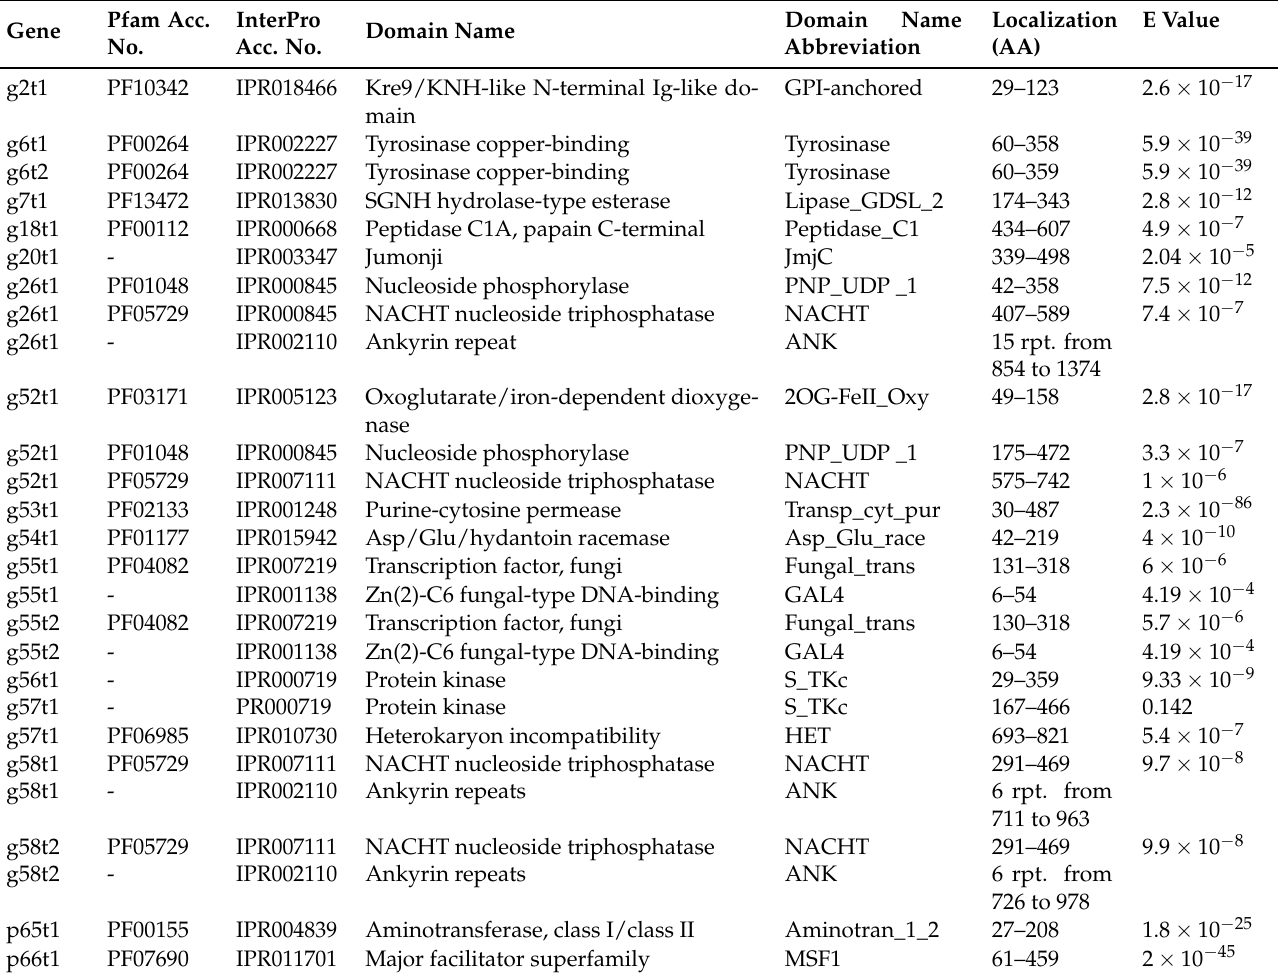
Table A3. Protein domains identified by InterPro scan and SMART in putative F. circinatum proteins.